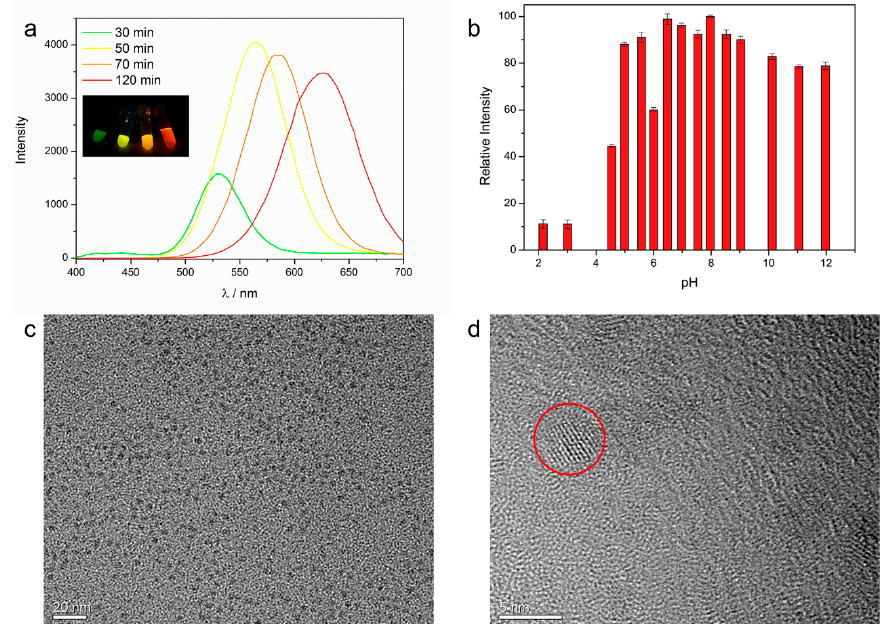
Figure 1. ( a ) Fluorescence spectra of β CD-CdTe at different reflux time ( λ ex = 380 nm). Insert is the photograph of the corresponding β CD-CdTe solutions (a small amount of the reaction solution is taken out at specific times during the reflux process) under ultraviolet lamp ( λ ex = 365 nm). From left to right: 30, 50, 70, 120 min. ( b ) Relative fluorescence intensity of β CD-CdTe under different pH conditions (PBS, 50 mM, β CD-CdTe: 5 mg/mL). The fluorescence intensity of β CD-CdTe at pH = 7.97 is set as 100%. ( c ) TEM (scale bar: 20 nm); and ( d ) high-resolution TEM (HRTEM, scale bar: 5 nm) images of β CD-CdTe dispersed in ultrapure water. One of the β CD-CdTe nanocrystals is marked by a red circle in the HRTEM image.